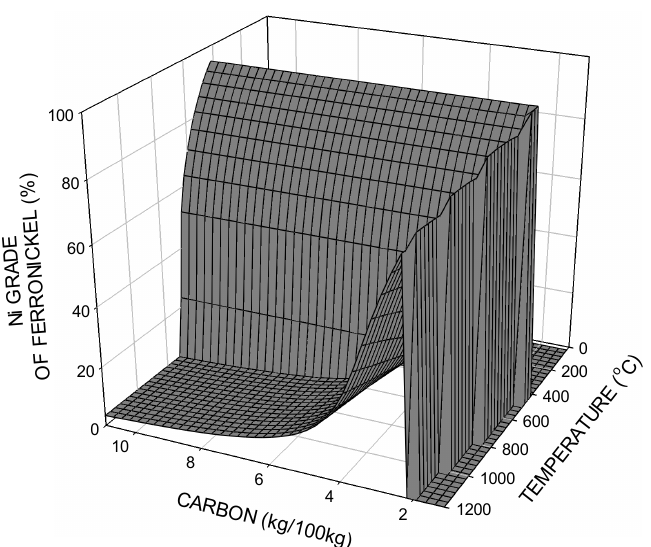
Figure 3. Effects of temperature and carbon additions on the nickel grade of the limonitic ore.